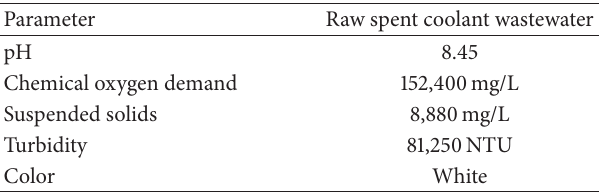
Table 2: Characteristics of spent coolant